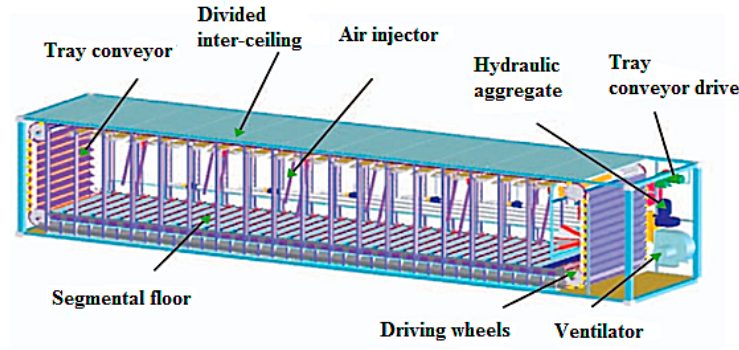
Figure 2. Ecological waste apparatus (EWA) bioreactor cross-section [44].